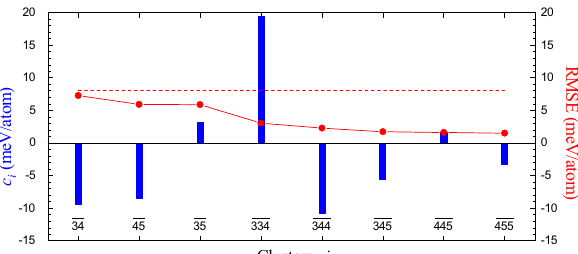
Fig. 6 Strength of the expansion coef fi cients (left vertical axis) and RMSE (right vertical axis) in the description of [111] BCC phases using a linear model based on blocks with Sn atoms separated by 3, 4, or 5 layers. The ∣ 3453 ∣ , phase, for example, has N 3 = N 5 = N 345 = 1 and N 4 = N 34 = N 45 = 2 in Eqn. (1) (symmetric combinations, such as 34 and 43 , are grouped together). The RMSE was calculated for a different number of expansion terms from 3 ({ 3 , 4 , 5 } giving 8.1 meV/atom marked with the dashed red line) to 11. The displayed coef fi cient strengths were evaluated for the full set of 11